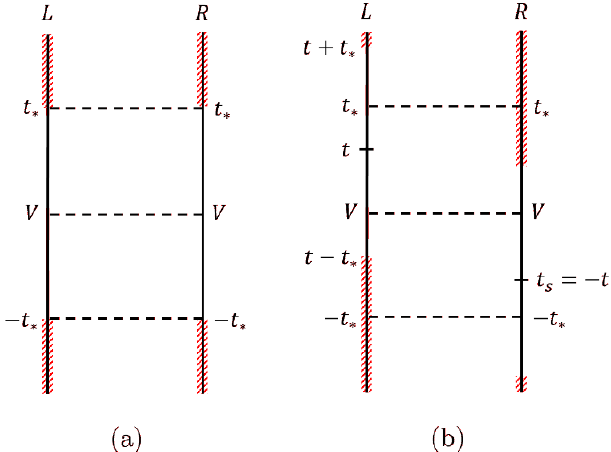
Figure 4 . The regenesis phenomenon is destroyed by insertion of (cid:13) from either side when t 0 is in the red shaded regions. (a) shows the destruction by diminishing e(cid:11)ective coupling when j t 0 j (cid:29) t (cid:3) , and (b) shows the destruction by diminishing J L J R correlation when j t (cid:0) t 0 j (cid:29) t (cid:3) . in which case insertion of (cid:13) L will destroy the correlation between points ( t; ~x ) and ( (cid:0) t